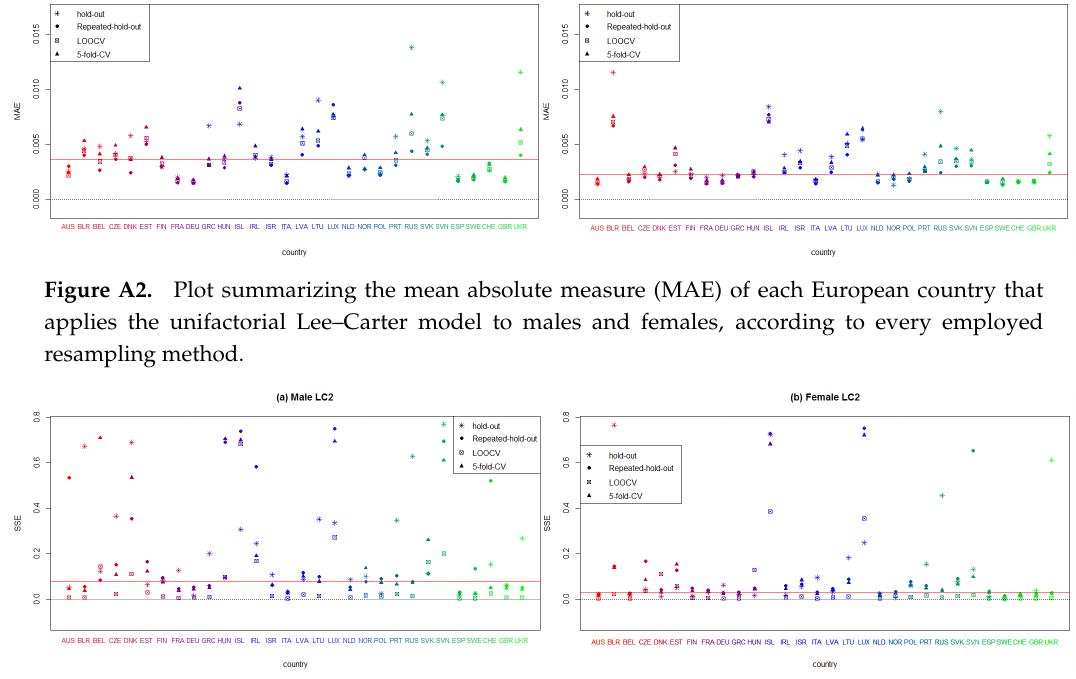
Figure A3. Plot that summarizing the sum of squares errors (SSE) of each European country that applies bifactorial Lee–Carter model to males and females, according to every employed resampling method.